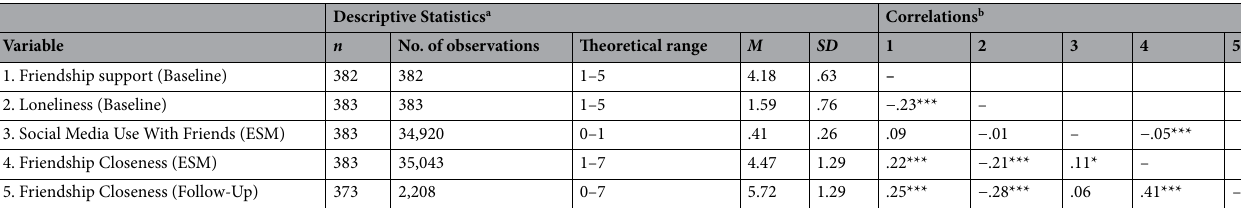
Table 1. Descriptive statistics and correlations of main study variables. a Means of friendship closeness and social media use with friends represent the average of the person-mean scores. For social media use with friends, these person-mean scores reflect the proportion of occasions during which participants used social media with friends (i.e., adolescents used social media with friends at 41% of the occasions). b Within-person correlations are presented above the diagonal and between-person correlations below the diagonal. * P ≤ .05, ** P ≤ .01, *** P ≤